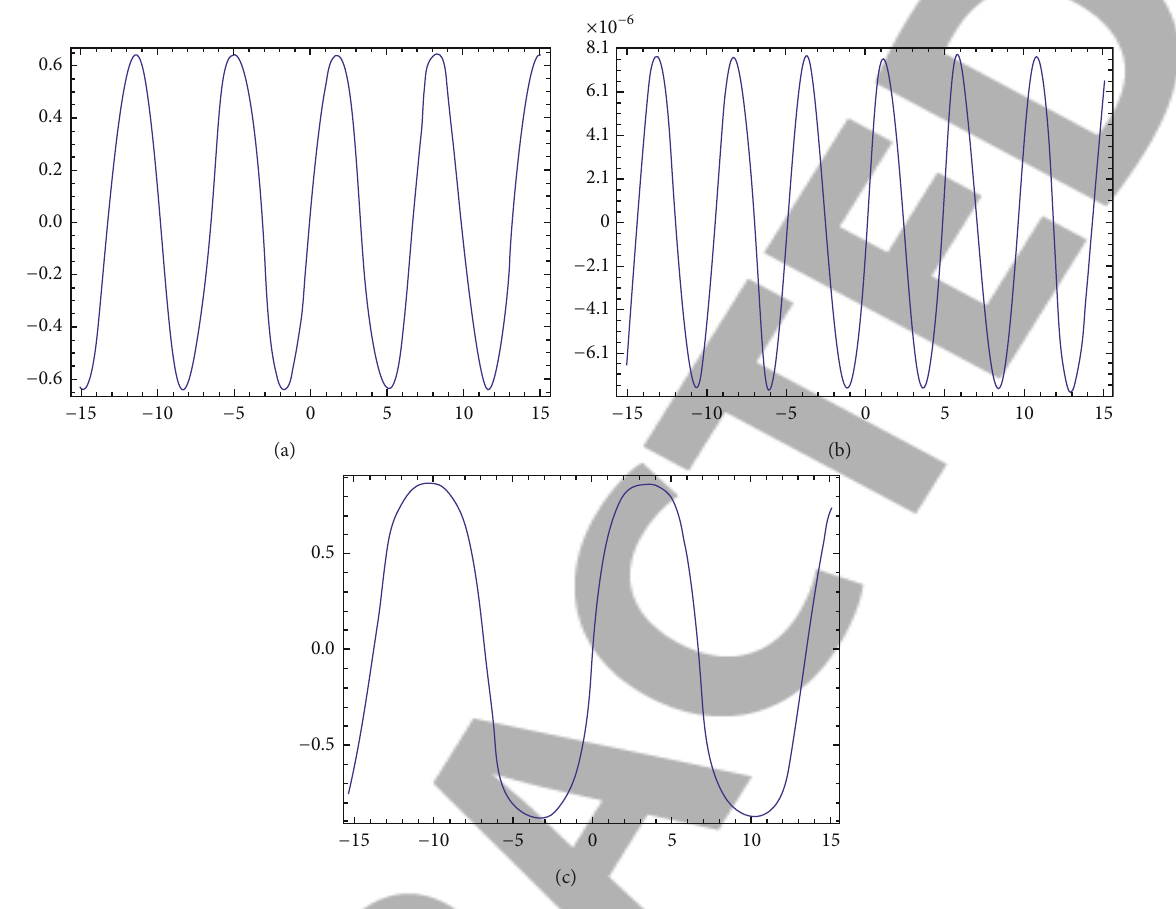
Figure 7: Simulation of periodic waves corresponding to periodic orbits inside heteroclinc cycle of (7). (a) Medium period. (b) Short period. (c) Long period.